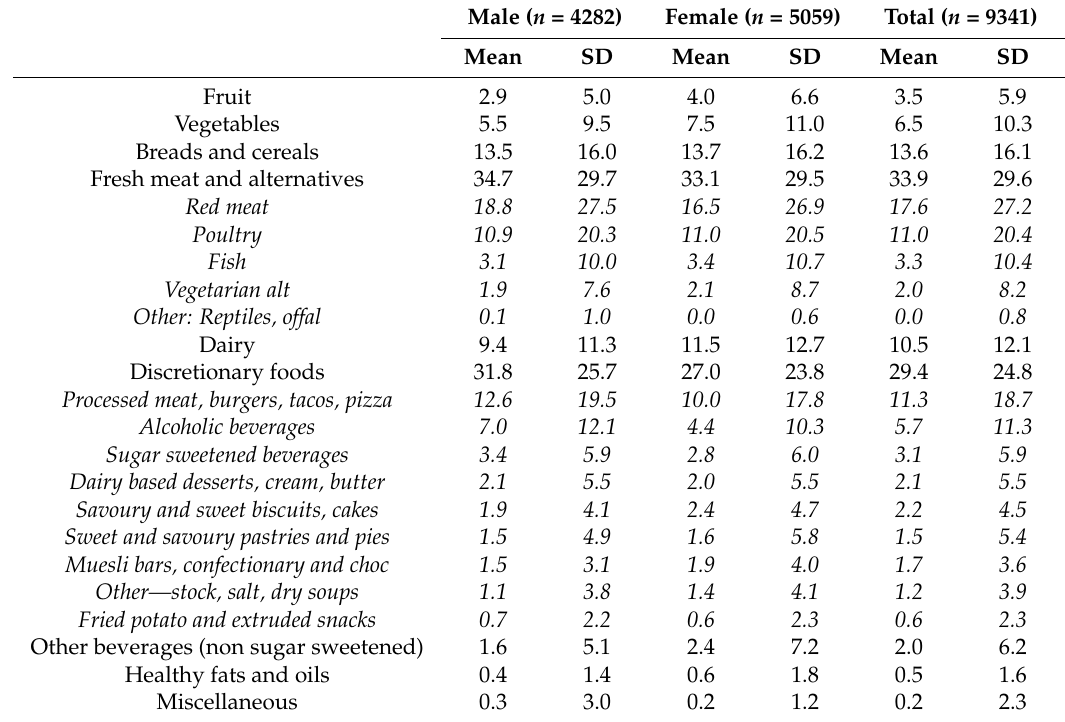
Table 2. Average percentage contribution of food groups to total dietary greenhouse gas emissions for Australian males and females.